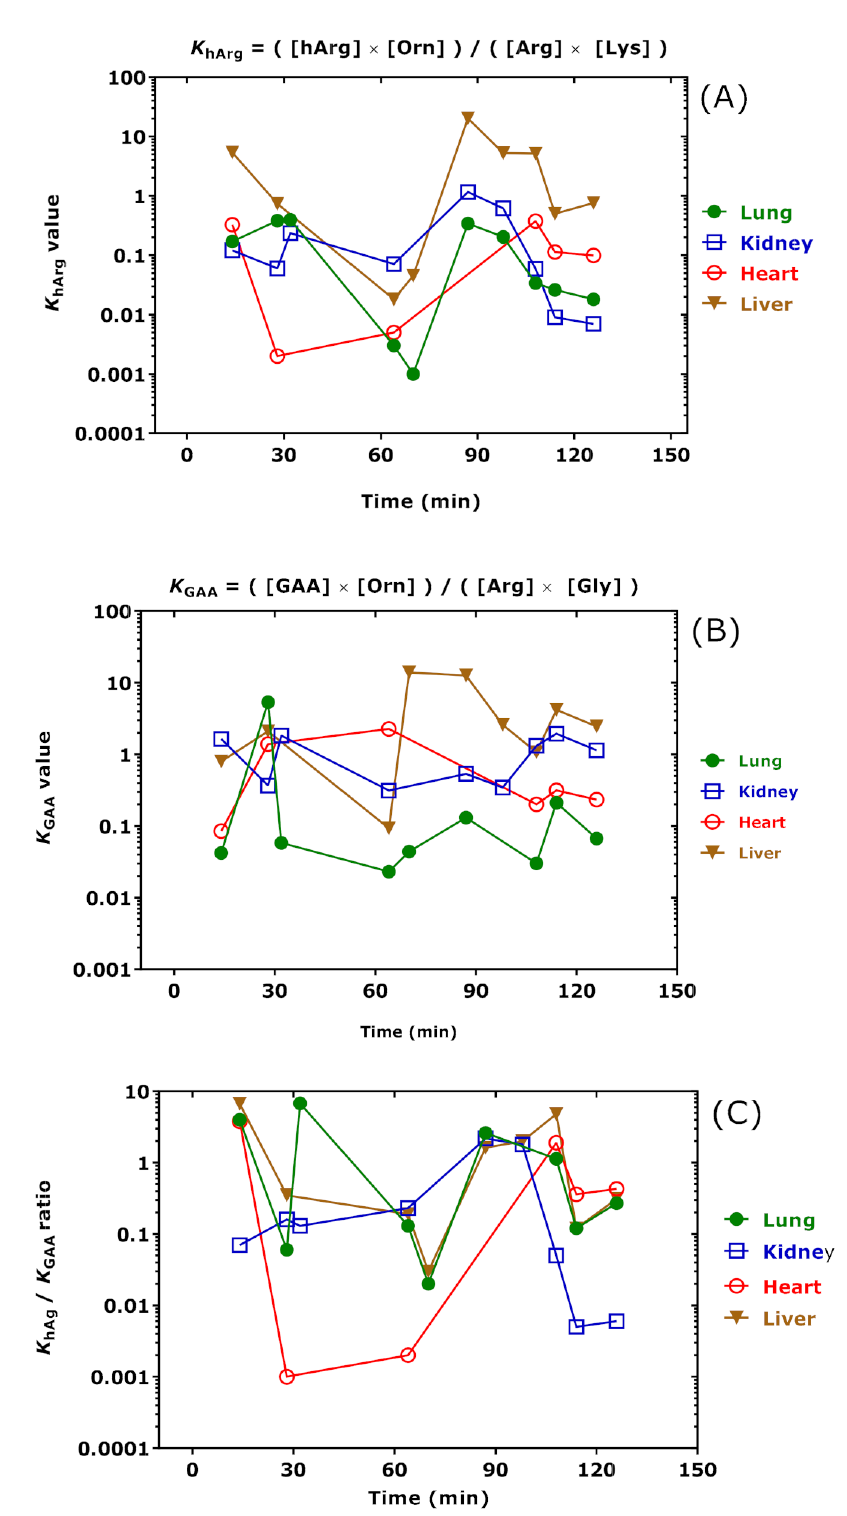
Figure 11. ( A ) Equilibrium constant ( K hArg ) values of the AGAT-catalyzed reaction Arg + Lys ↔ hArg + Orn; ( B ) equilibrium constant ( K GAA ) values of the AGAT-catalyzed reaction Arg + Gly ↔ GAA + Orn; and ( C ) K hArg / K GAA values in the organs of the rats at the time of sacrifice upon i.p. administration of the indicated doses of hArg. The Figure was constructed using the data listed in Table 4. Note the logarithmic scale on the y